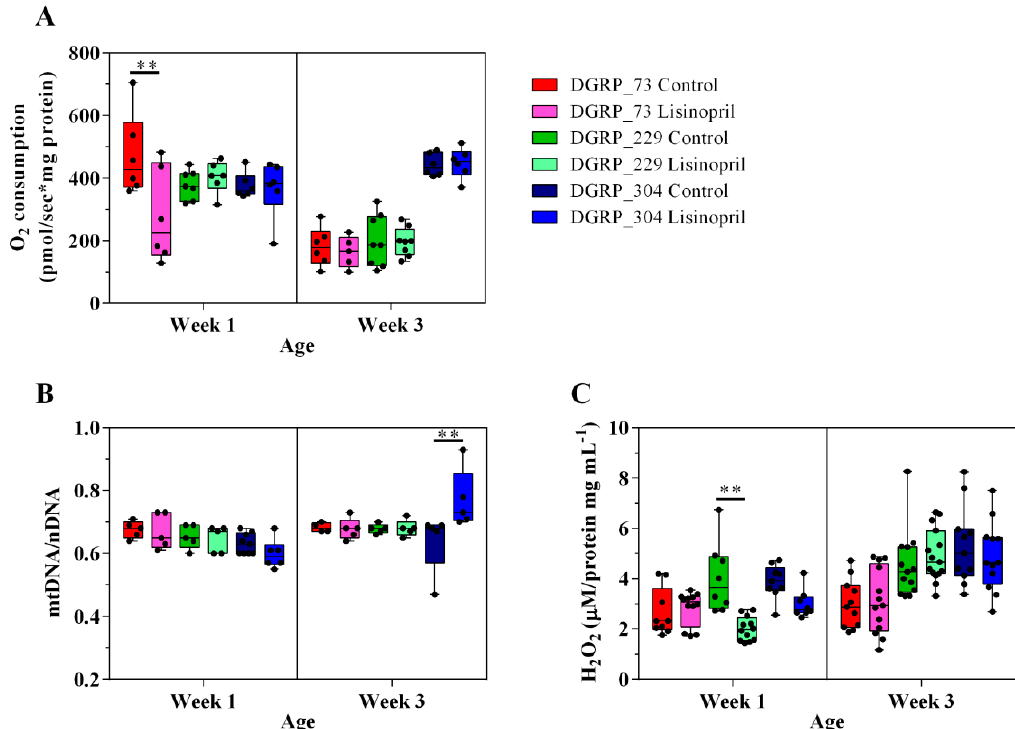
Figure 1. Lisinopril treatment alters thoracic mitochondrial function and content as well as H 2 O 2 levels in a genotype- and age-specific manner. ( A – C ) Lisinopril significantly reduces state 3 respiration of mitochondria isolated from the thoraces of DGRP_73 young flies (panel A ), increases thoracic mitochondrial content in DGRP_304 middle-aged flies (panel B ), and decreases H 2 O 2 levels in DGRP_229 young flies (panel C ). Box and whiskers plots denote individual data points separated by a line representing the group median. Each individual value is plotted as a dot superimposed on the boxplots. In all panels, ** p < 0.01, obtained from Tukey post hoc tests for multiple comparisons.